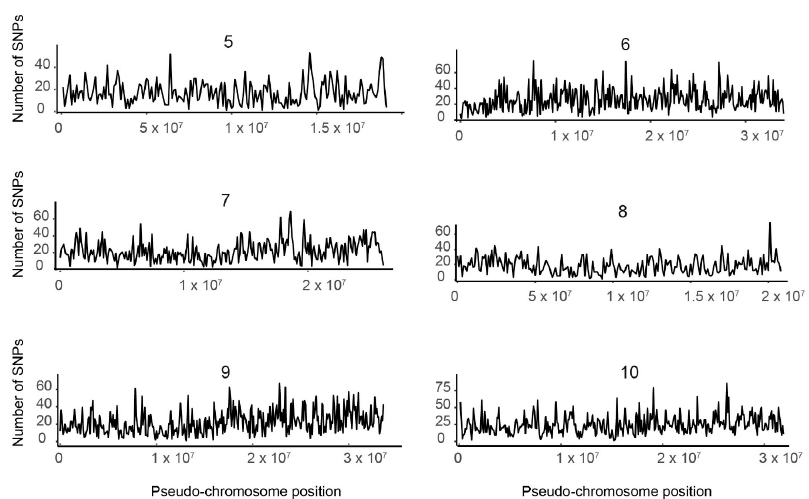
Figure 1. Distribution of single nucleotide polymorphisms (SNPs) by pseudo-chromosome. The number of SNPs ( y -axis) is plotted by nucleotide position on each of the 10 tef pseudomolecules ( x -axis). Each graph was generated using SNP data from an individual pseudomolecule. The number above each graph indicates the pseudomolecule.